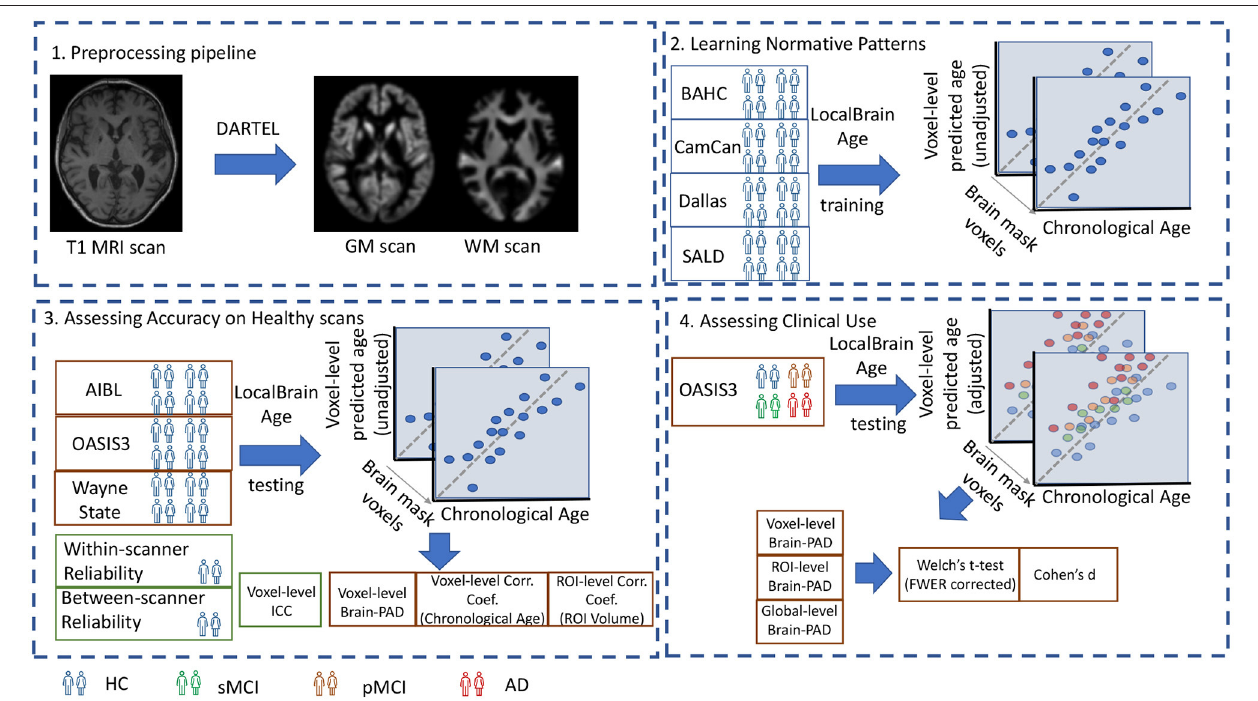
FIGURE 1 | 1. Preprocessing pipeline: T1-weighted MRI scans from all datasets were tissue segmented and non-linearly registered using SPM12 to generate modulated grey and white matter volume maps. 2. Learning Normative Patterns: Randomly subsampled participants from BAHC, CamCan, Dallas, and SALD were used to train the local brain-age U-net to learn predict chronological age locally. 3. Assessing Accuracy on Healthy scans: Using healthy scans from AIBL, OASIS3 and Wayne State we tested age prediction accuracy on unseen data from independent datasets. 4. Assessing Clinical Use: Using the OASIS3 dataset (healthy controls, stable MCI, progressive MCI, and AD participants), we compared groups at voxel, regional and global